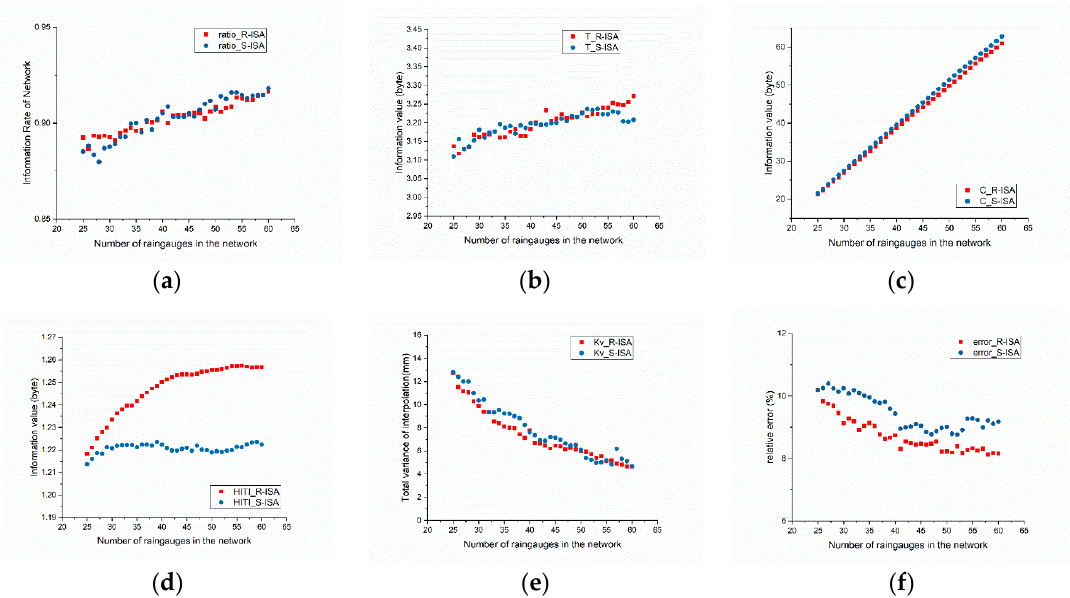
Figure 18. Comparison of the R-ISA and S-ISA methods. ( a ) Statistical diagram of the percentage of joint entropy of the network; ( b ) statistical diagram of mutual information between the network and potential station sets; ( c ) statistical diagram of the information redundancy of the network; ( d ) statistical diagram of the average SI of the network; ( e ) statistical diagram of the daily mean kriging variance of the network and ( f ) statistical diagram of the relative errors of the network.